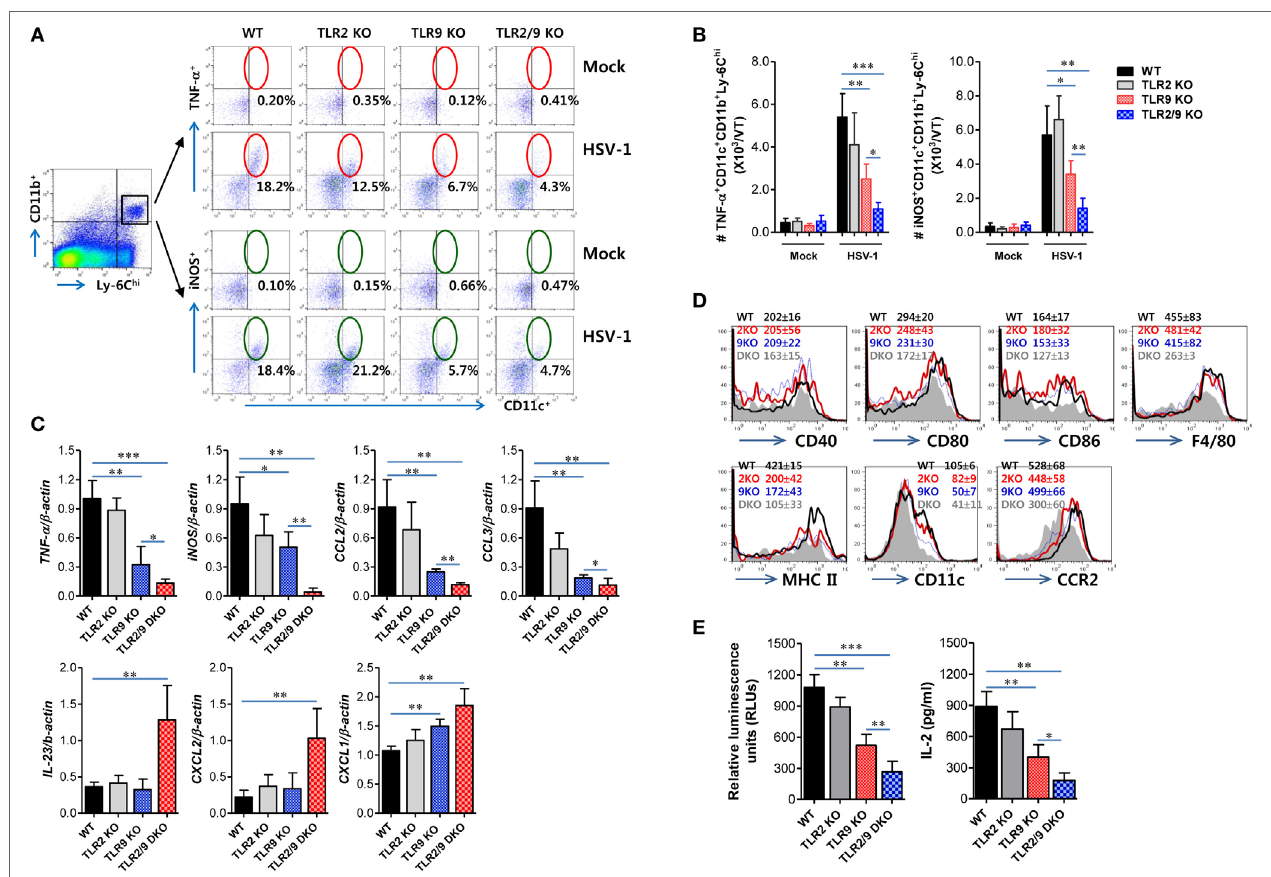
FigUre 6 | Dual TLR2/9 recognition of herpes simplex virus type 1 to promote the differentiation of Ly-6C hi monocytes in TNF- α + iNOS + CD11c + TNF- α and iNOS-producing dendritic cells (Tip-DCs). (a) The frequency of Tip-DCs in the vaginal tract (VT) of infected mice. Cells were prepared from the VT with collagenase digestion 0 and 2 days post-infection (dpi) and used for analysis of Tip-DCs. Tip-DCs were detected by intracellular TNF- α or iNOS staining combined with surface staining for CD11c, Ly-6C, and CD11b. The values in the dot-plots represent the average percentage of TNF- α + or iNOS + CD11c + after gating on CD11b + Ly-6C hi cells. (B) The total number of accumulated TNF- α + or iNOS + CD11c + CD11b + Ly-6C hi Tip-DCs in the VT. (c) The cytokine expression profile of sorted CD11b + Ly-6C hi monocytes in the VT. Total RNA was extracted from sorted CD11b + Ly-6C hi monocytes in the VTs 2 dpi and used for real-time qRT-PCR. (D) Phenotypic levels